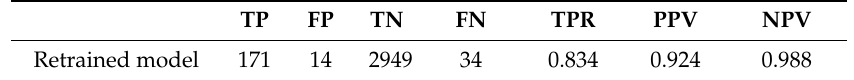
Figure 3. ROC curve and Precision-Recall Curve for modified model. These two curves are the most common measures to demonstrate the performance of a prediction model. Our model showed a F1 score of 0.877 and the area under ROC is 0.809 indicating a good precision and recall performance. This means our model is very accurate and has a high sensitivity and specificity. Table 4. Performance of model retrained on selected features.